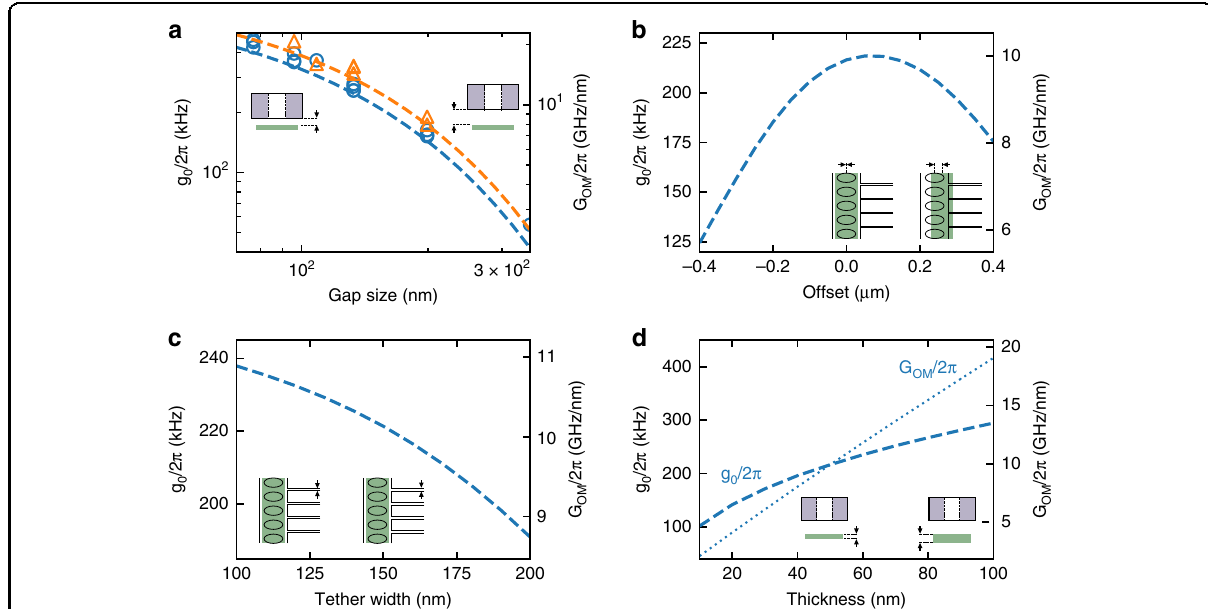
Fig. 2 Optomechanical coupling rate. Optomechanical coupling rate g 0 and strength G OM for different a gap sizes, b misalignment or offsets, c widths of the clamping tethers, and d thickness of the mechanical layer. The dashed lines are simulations, while the circles and triangles in ( a ) are measurement results. The blue and orange color distinguish the different widths of the mechanical part directly under the photonic crystal (0.8 and 1.0 µm, respectively). In ( d ), the change of thickness changes the effective mass. g 0 and G OM are plotted separately with a dashed and dotted line,